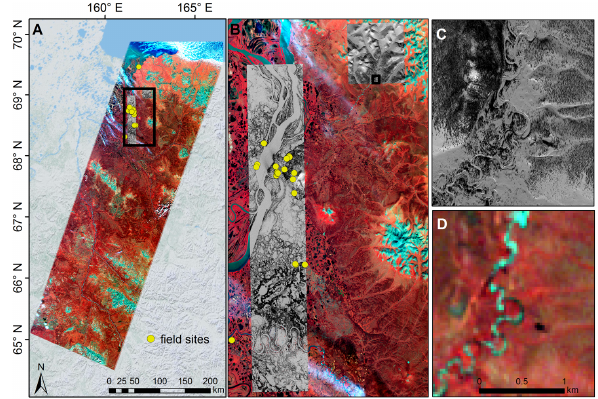
Fig. 2. Maps of the northeastern portion of the Kolyma River water- shed showing the field sampling locations, as well as the (a) Landsat 5 and (b) WorldView-1 satellite imagery used in the analysis. To il- lustrate the large difference in spatial resolution between sensors, Fig. 2c, d show close-up views for WorldView-1 and Landsat 5, re- spectively. The Landsat 5 imagery is displayed using bands 4, 3, 1